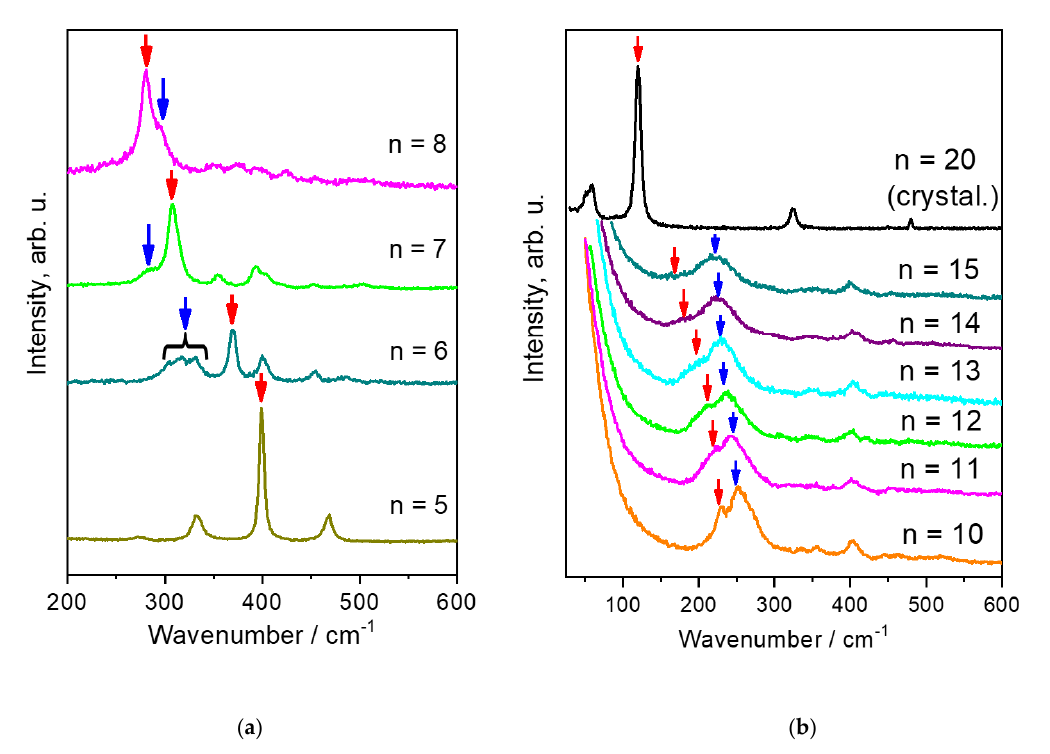
Figure 2. Raman spectra of linear short-chain ( a ) and long-chain ( b ) linear alkanes in the region of longitudinal acoustic mode (LAM; red arrows) and disorder LAM (D-LAM; blue arrows)